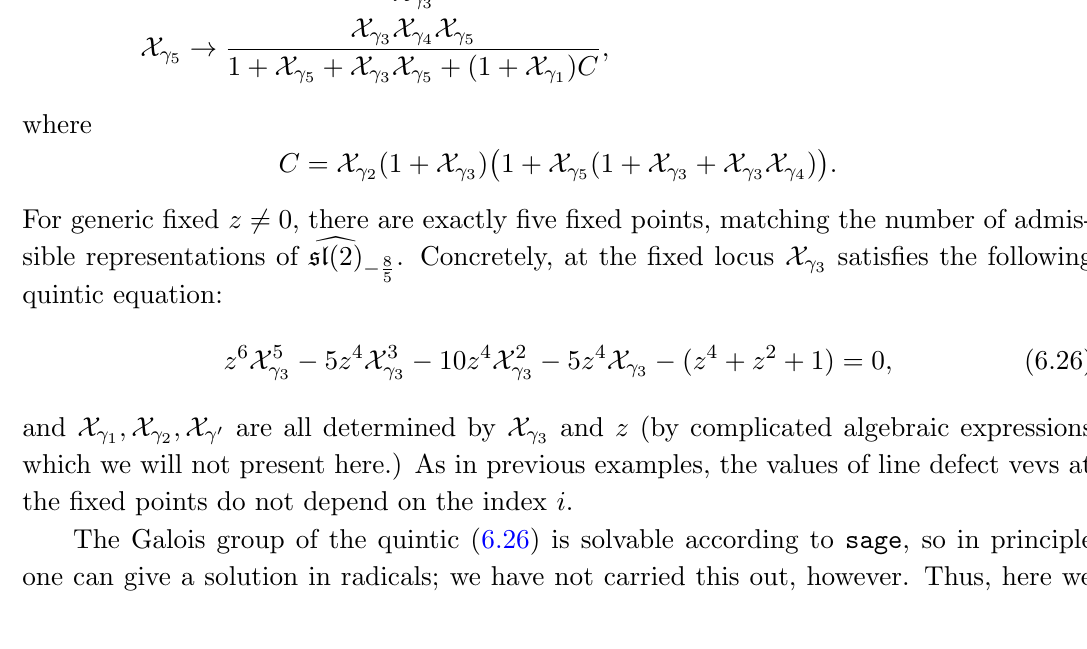
Figure 21. Monodromy action as a sequence of (cid:13)ips in the ( A 1 ; D 5 ) Argyres-Douglas theory. 1 + X + X X + (1 + X ) (cid:13) 5 (cid:13) 3 (cid:13) 5 (cid:13) 1 X ! (cid:13) 4